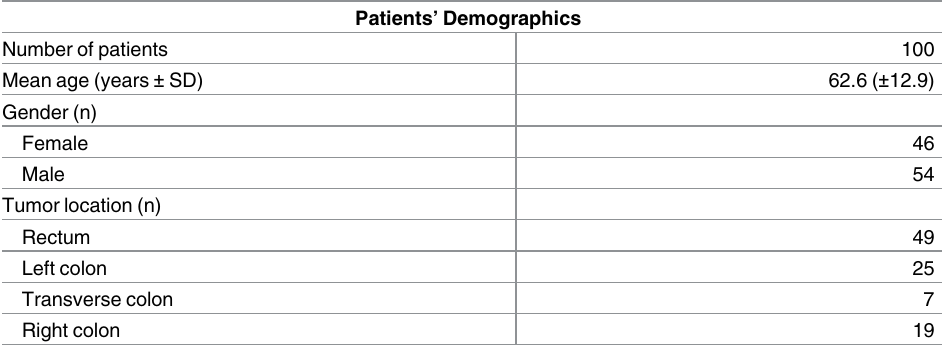
Table 2. Clinical and demographics data of patients included in the